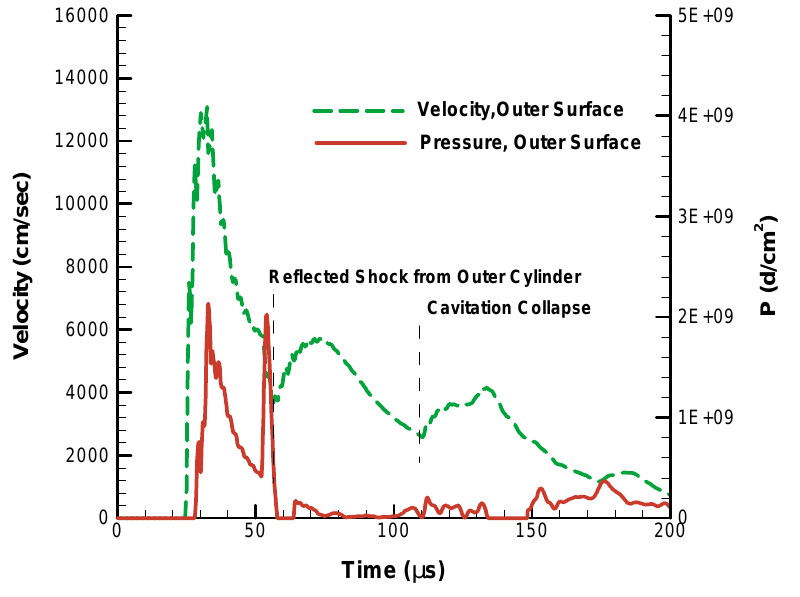
Fig. 17. Computed velocity of the outside of the inner wall at the midline for the double wall